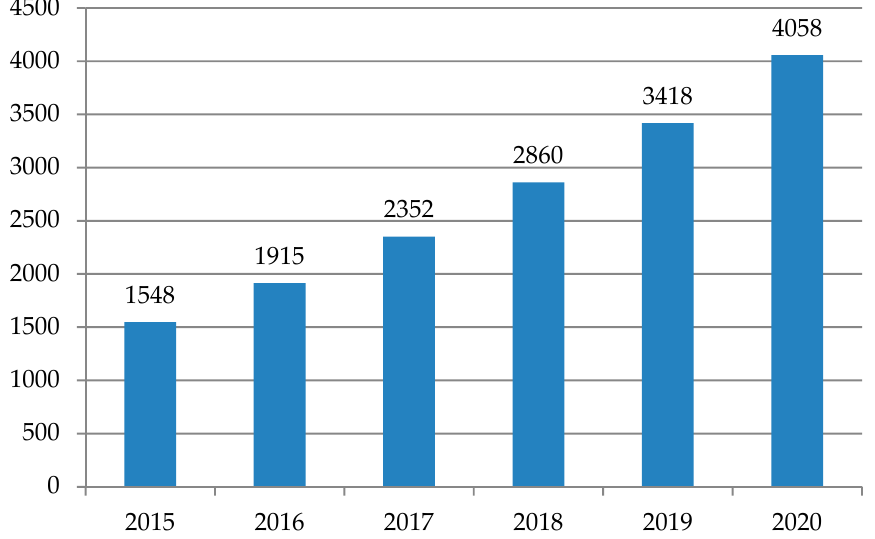
Figure 2. Volumes of retail e-commerce for 2015–2019 and forecast for 2020. The total sales in e-commerce are shown in Figure 3 (billion USD).